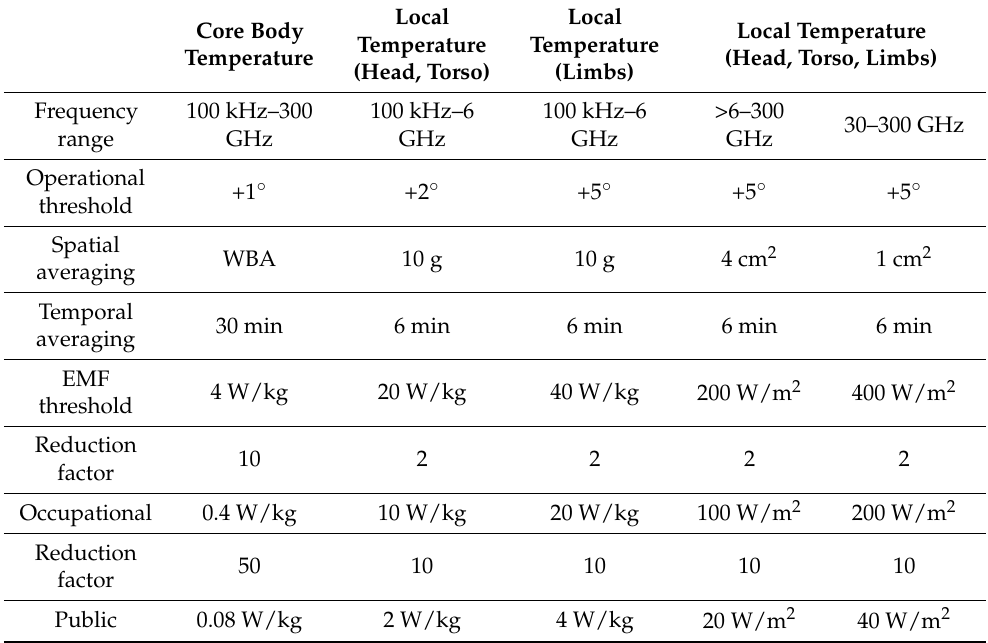
Table 1. ICNIRP steady-state operational-thresholds and basic restrictions for occupational and public exposures